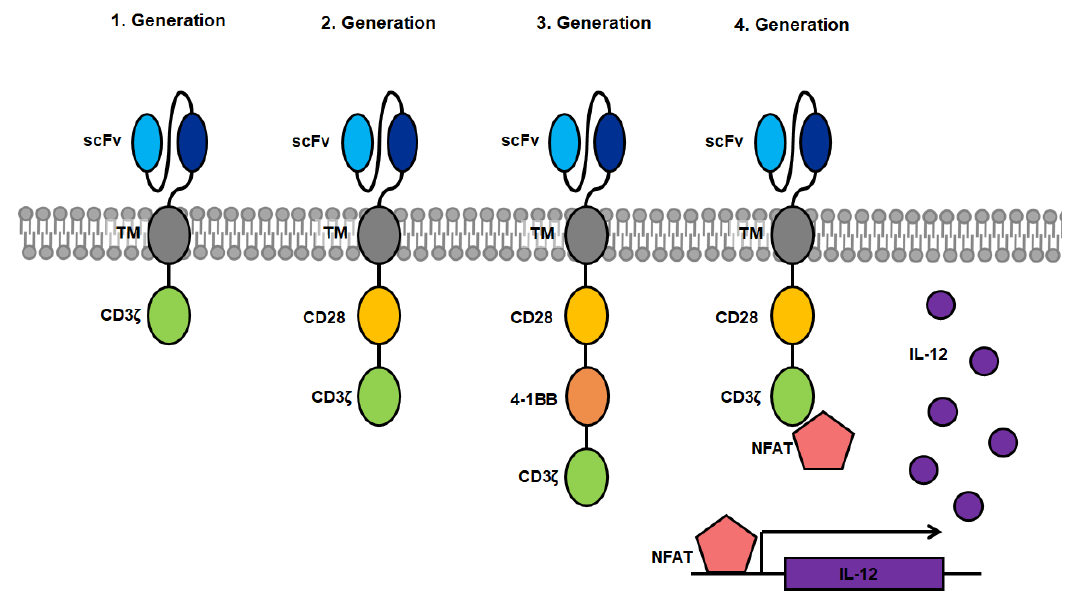
Figure 1. Overview of CAR designs from first to fourth generation. Blue: single-chain variable fragment (scFv) consisting of the heavy and light chain of the binding domain of antigen-specific antibodies coupled by a linker peptide; grey: transmembrane domain; yellow: co-stimulatory domain of CD28; orange: co-stimulatory domain of 4-1BB (CD137); green: activating domain consisting of the CD3 ζ domain of the T-cell receptor; pink: nuclear factor of activated T-cells (NFAT); purple: interleukin-12 (IL-12) which is expressed after binding of NFAT to an NFAT-driven IL-12 cassette.